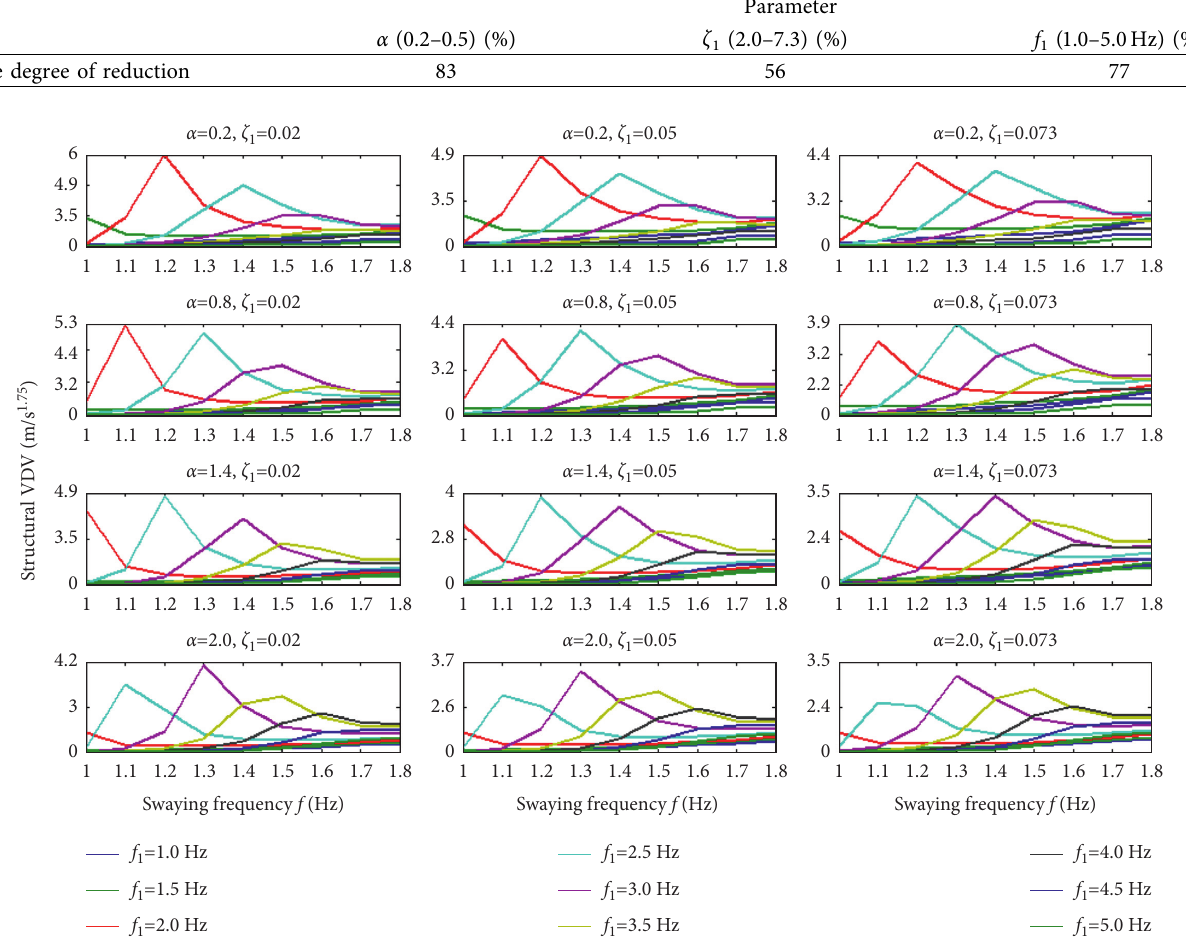
Figure 29: The structural VDV results when f